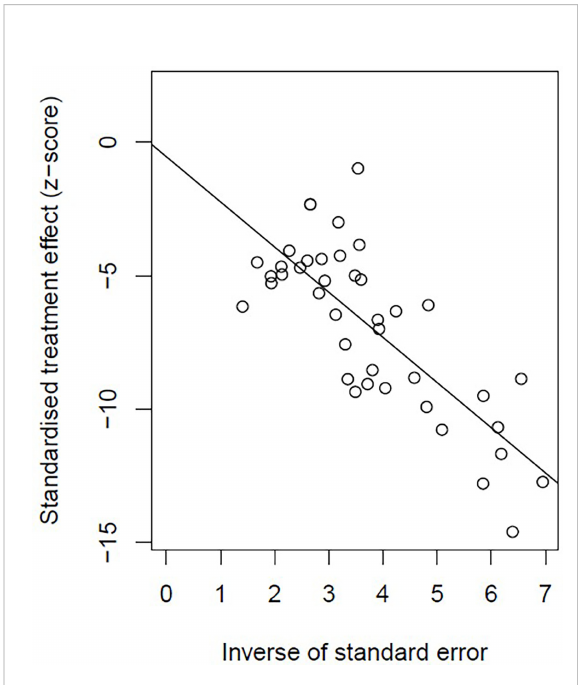
FIGURE 5 Plot of Egger ’ s test illustrating the publication bias of meta-analysis of overall pooled incidence rate of hyperprogressive disease. FIGURE 6